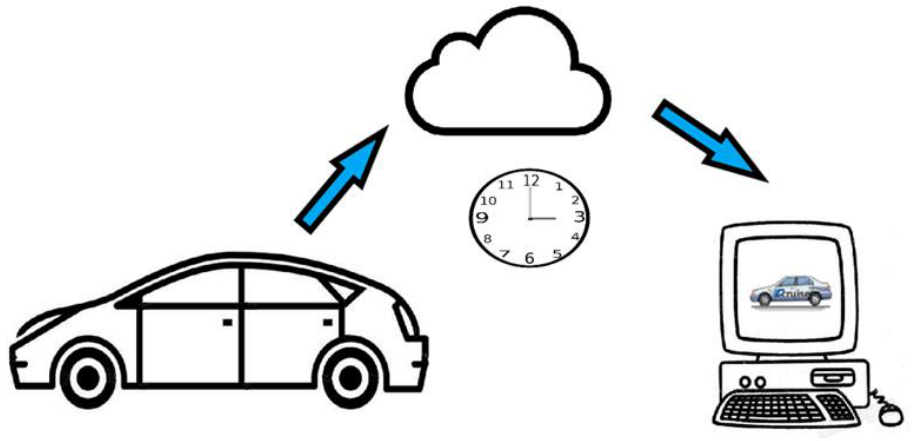
Figure 7. Data transmission diagram of the real-time optimization process of the model.